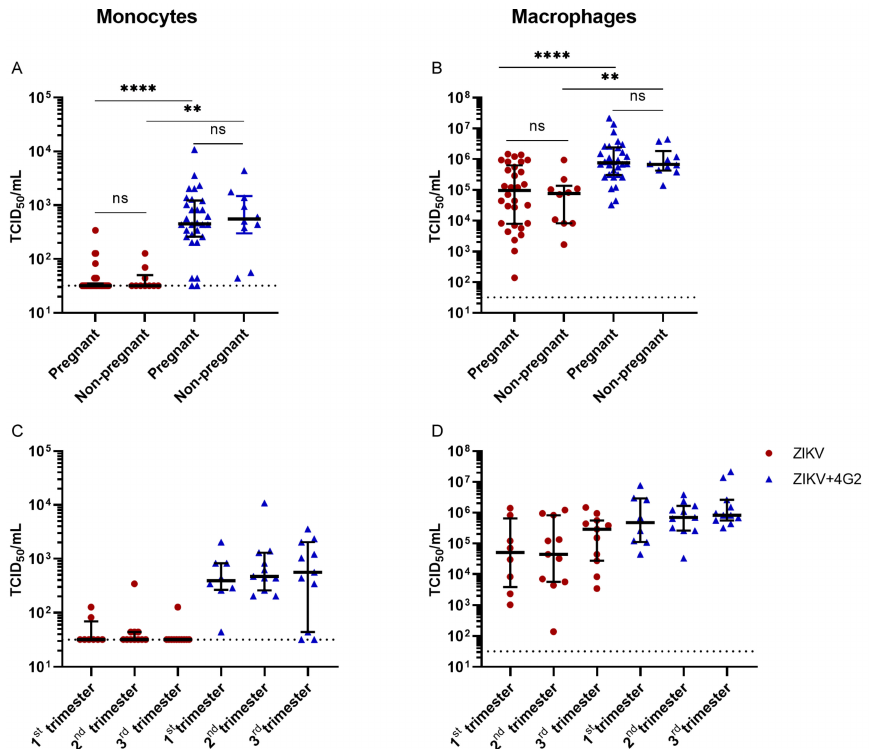
Figure 6. No differences in permissiveness for ZIKV infection and ADE of ZIKV infection in mono- cytes ( A ) or monocyte-derived macrophages ( B ) from pregnant women compared to